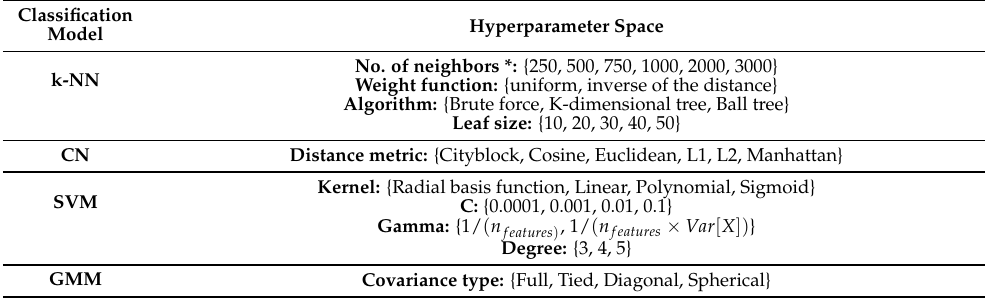
Table A1. Hyperparameter spaced used for each classification model.